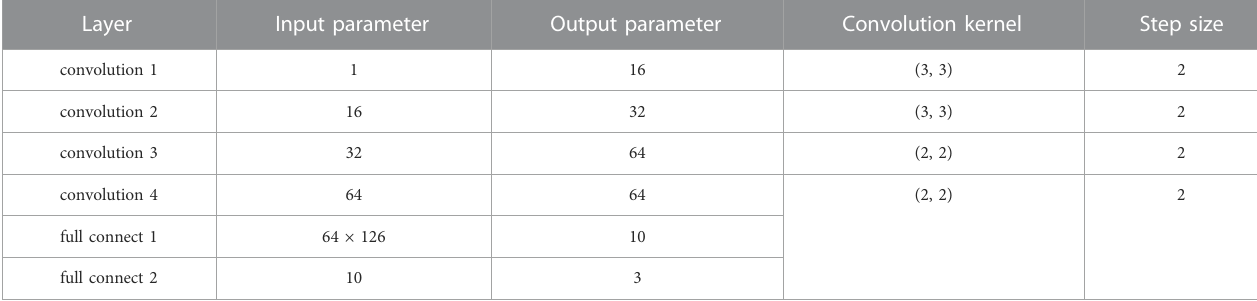
TABLE 5 CNN-dropout network